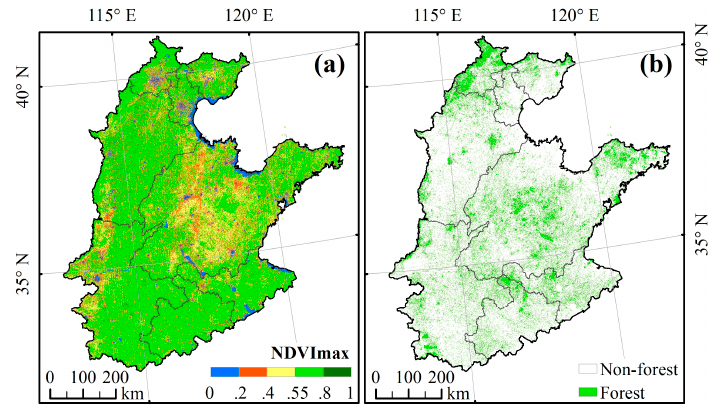
Figure 2. Spatial distribution of annual maximum NDVI ( a ) and the PALSAR-based forest map ( b ) in the North China Plain (NCP) in 2010.